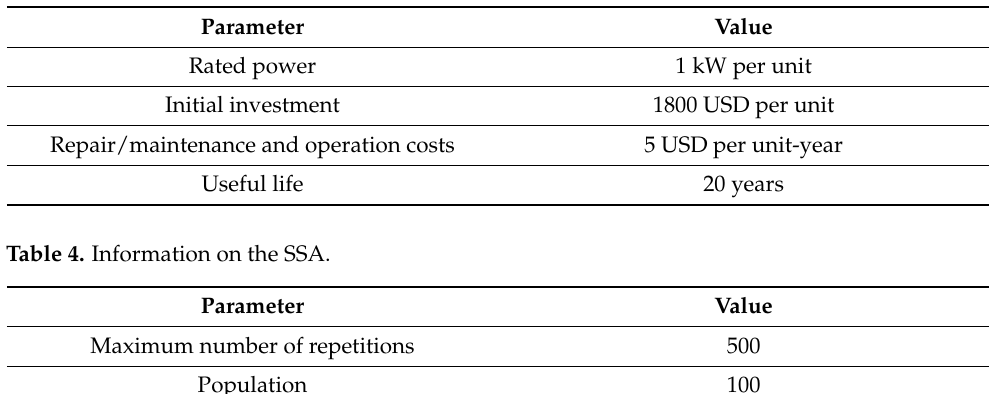
Table 3. Solar array parameters.